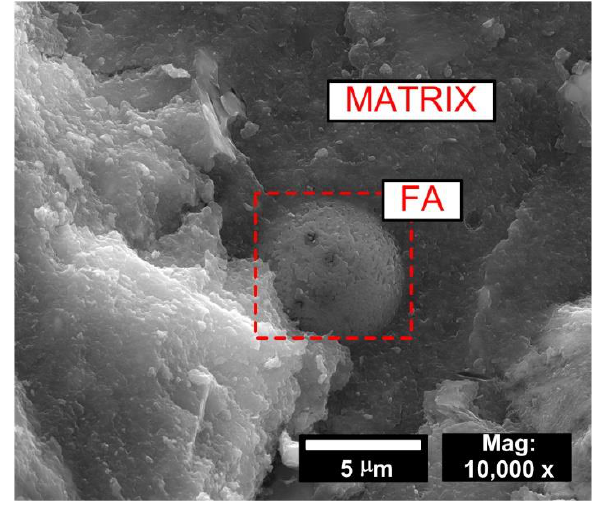
Figure 9. Fly ash grain during pozzolanic reaction.